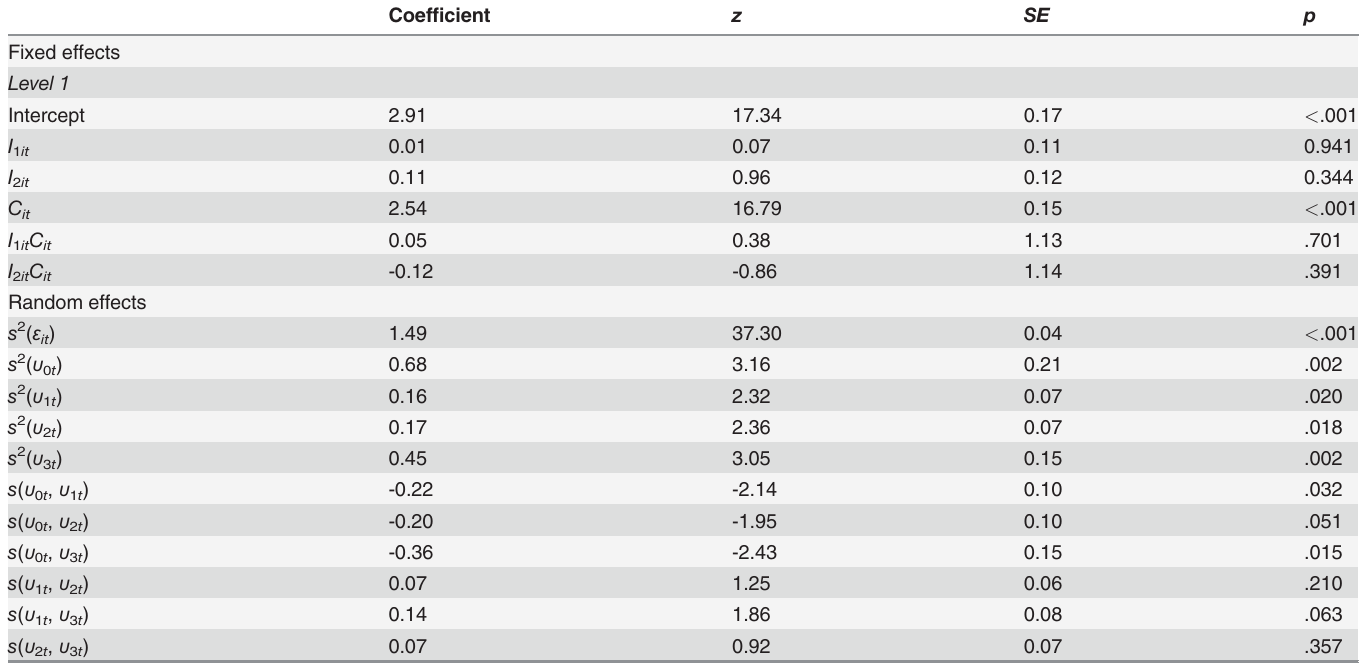
Table 3. Results of the pre-study (Model